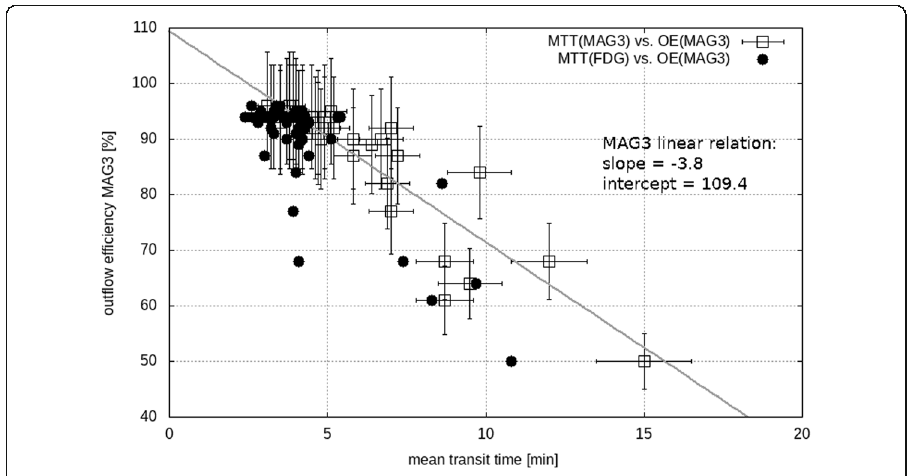
Fig. 4 Outflow efficiency (OE) of the reference (ref) tracer MAG3 versus MAG3 mean transit time (MTT), squares, and versus FDG, circles. Correlation between MAG3 OE and MTT was − 0.90; the slope and intercept of the linear regression is also shown. Correlation between MAG3 OE and FDG MTT was −